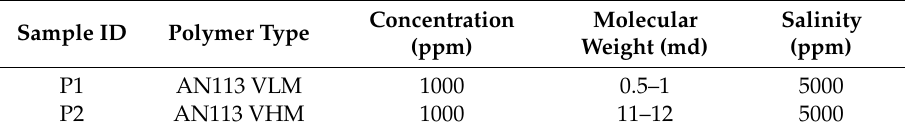
Table 2. Polymer solution composition.